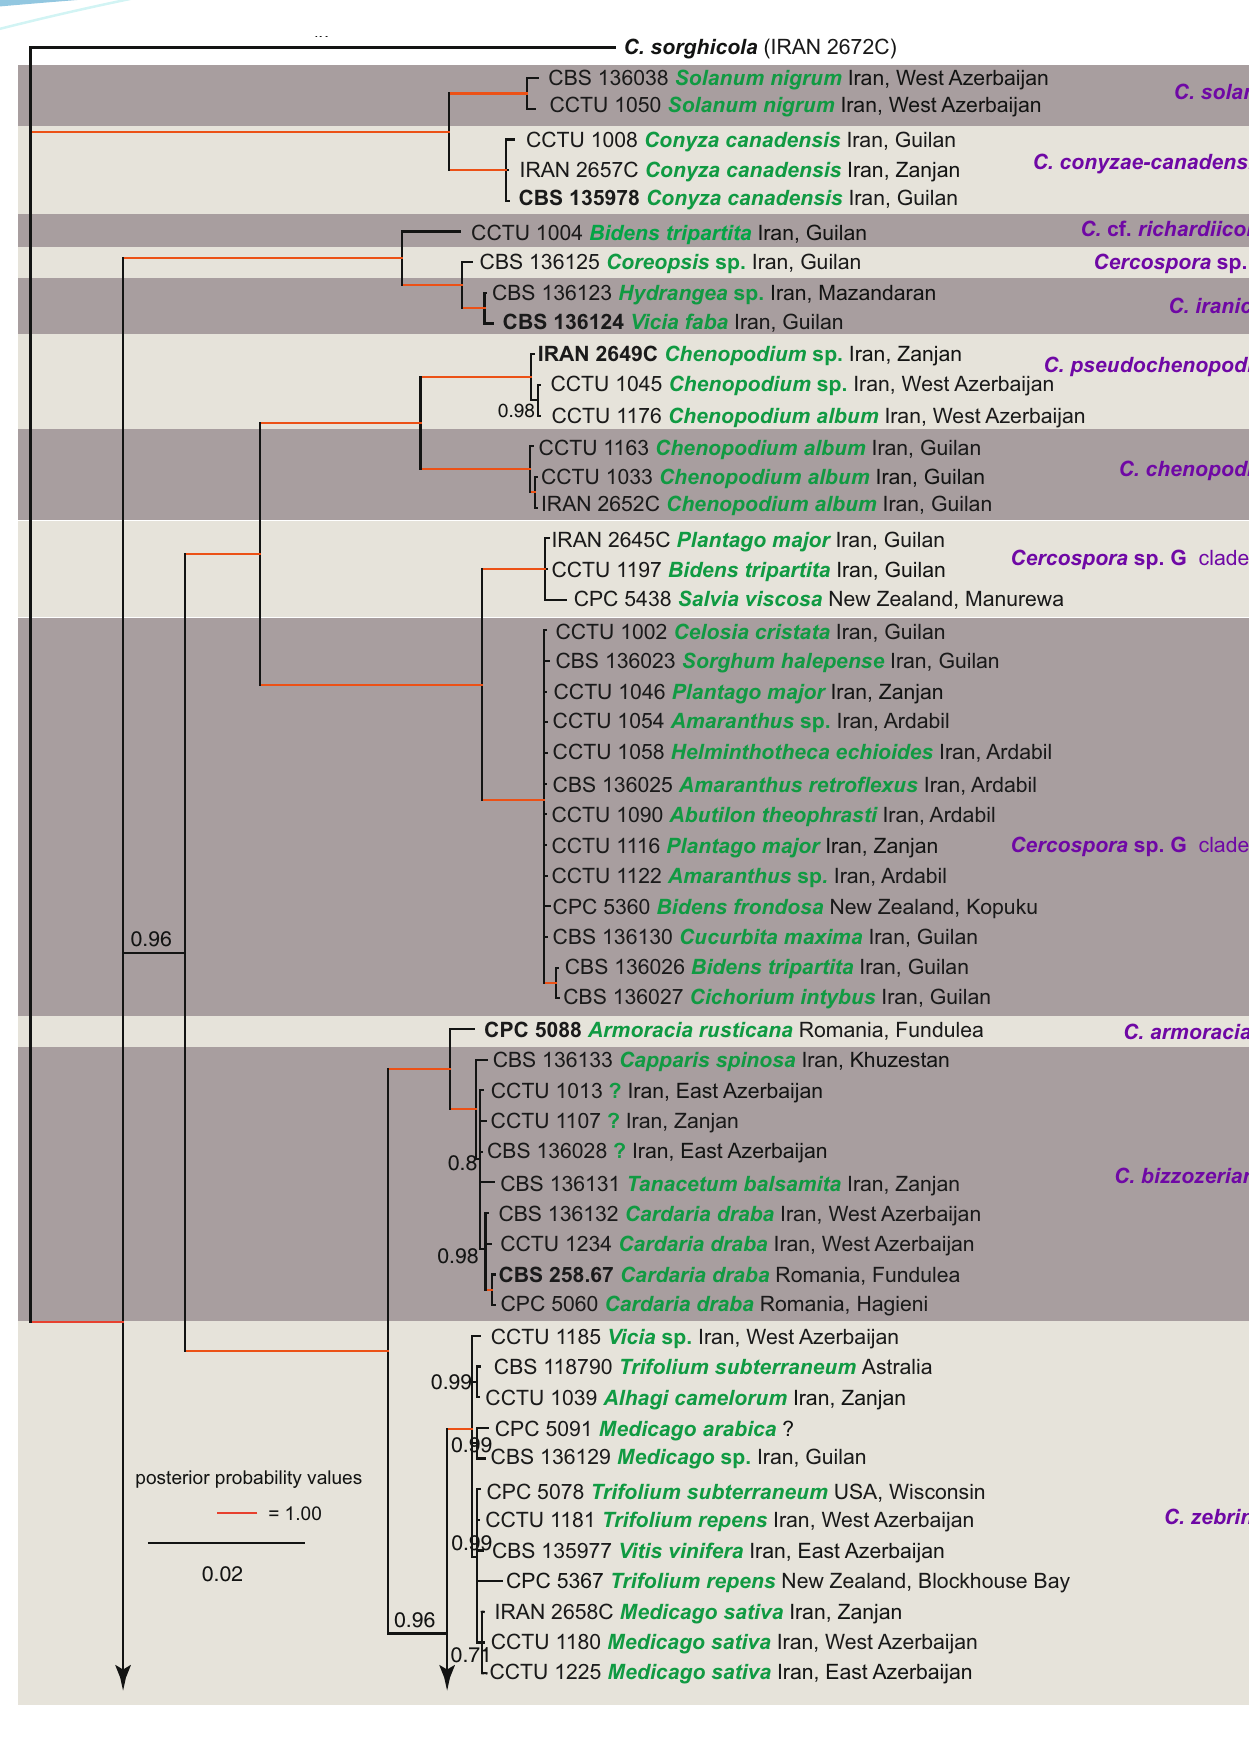
Fig. 1. %(cid:4)(cid:17)(cid:7)(cid:13)(cid:17)(cid:7)(cid:5)(cid:7)(cid:2)(cid:18)(cid:14)(cid:22)(cid:23)(cid:4)(cid:25)(cid:10)(cid:9)(cid:6)(cid:2)(cid:24)0+(cid:2)(cid:133)(cid:2)(cid:6)(cid:9)P(cid:4)(cid:10)(cid:11)(cid:8)(cid:22)(cid:2)(cid:10)(cid:5)(cid:23)(cid:13)(cid:27)(cid:2)(cid:4)(cid:26)(cid:2).(cid:2)$!+(cid:2)(cid:8)(cid:10)(cid:13)(cid:13)(cid:7)(cid:2)(cid:10)(cid:13)(cid:7)(cid:5)(cid:23)(cid:8)(cid:11)(cid:17)(cid:25)(cid:2)(cid:26)(cid:10)(cid:4)(cid:6)(cid:2)(cid:9)(cid:2)’(cid:9)(cid:22)(cid:13)(cid:7)(cid:11)(cid:9)(cid:17)(cid:2)(cid:9)(cid:17)(cid:9)(cid:23)(cid:22)(cid:7)(cid:11)(cid:7)(cid:2)(cid:4)(cid:26)(cid:2)(cid:8)(cid:14)(cid:13)(cid:2)(cid:19)(cid:4)(cid:6)(cid:12)(cid:11)(cid:17)(cid:13)(cid:21)(cid:2)(cid:13)(cid:11)(cid:25)(cid:14)(cid:8)4(cid:25)(cid:13)(cid:17)(cid:13)(cid:2)(cid:7)(cid:13)T(cid:5)(cid:13)(cid:17)(cid:19)(cid:13)(cid:2) (cid:9)(cid:23)(cid:11)(cid:25)(cid:17)(cid:6)(cid:13)(cid:17)(cid:8)(cid:2)(cid:5)(cid:7)(cid:11)(cid:17)(cid:25)(cid:2)>(cid:10)’(cid:9)(cid:22)(cid:13)(cid:7)(cid:2);(cid:28)(cid:2).(cid:28)*(cid:28)*(cid:28)(cid:2)<(cid:14)(cid:13)(cid:2)(cid:7)(cid:19)(cid:9)(cid:23)(cid:13)(cid:2)(cid:12)(cid:9)(cid:10)(cid:2)(cid:11)(cid:17)(cid:21)(cid:11)(cid:19)(cid:9)(cid:8)(cid:13)(cid:7)(cid:2)+(cid:28)+*(cid:2)(cid:13)6(cid:18)(cid:13)(cid:19)(cid:8)(cid:13)(cid:21)(cid:2)(cid:19)(cid:14)(cid:9)(cid:17)(cid:25)(cid:13)(cid:7)(cid:2)(cid:18)(cid:13)(cid:10)(cid:2)(cid:7)(cid:11)(cid:8)(cid:13)(cid:28)(cid:2)X(cid:4)(cid:7)(cid:8)(cid:7)(cid:2)(cid:9)(cid:17)(cid:21)(cid:2)(cid:19)(cid:4)(cid:5)(cid:17)(cid:8)(cid:10)(cid:22)(cid:2)(cid:4)(cid:26)(cid:2)(cid:4)(cid:10)(cid:11)(cid:25)(cid:11)(cid:17)(cid:2)(cid:9)(cid:10)(cid:13)(cid:2)(cid:11)(cid:17)(cid:21)(cid:11)(cid:19)(cid:9)(cid:8)(cid:13)(cid:21)(cid:2)(cid:11)(cid:17)(cid:2)(cid:25)(cid:10)(cid:13)(cid:13)(cid:17)(cid:2)(cid:9)(cid:17)(cid:21)(cid:2) (cid:12)(cid:23)(cid:9)(cid:19)(cid:16)(cid:2)(cid:8)(cid:13)6(cid:8)(cid:29)(cid:2)(cid:10)(cid:13)(cid:7)(cid:18)(cid:13)(cid:19)(cid:8)(cid:11);(cid:13)(cid:23)(cid:22)(cid:28)(cid:2)<(cid:14)(cid:13)(cid:2)(cid:8)(cid:10)(cid:13)(cid:13)(cid:2)(cid:15)(cid:9)(cid:7)(cid:2)(cid:10)(cid:4)(cid:4)(cid:8)(cid:13)(cid:21)(cid:2)(cid:8)(cid:4) Cercospora sorghicola